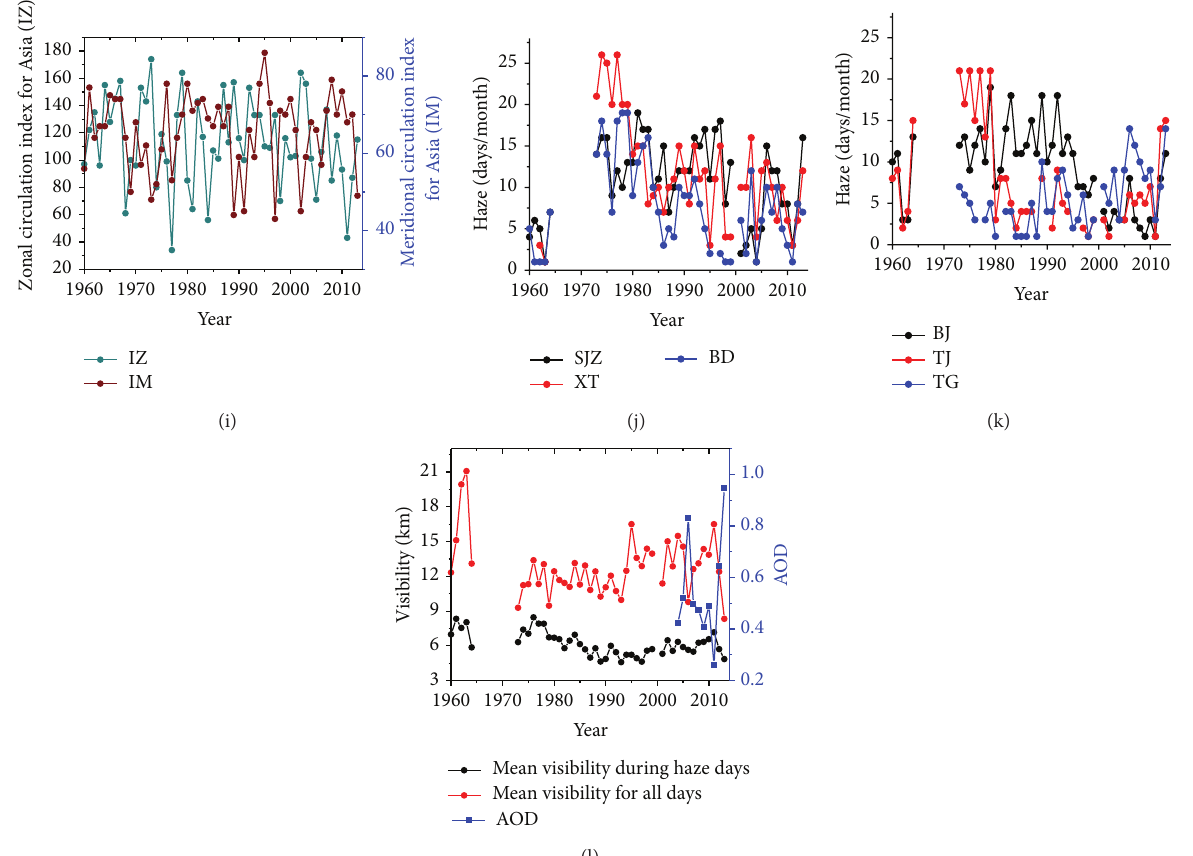
Figure 3: Interannual variations of (a) ∼ (e) precipitation, wind speed, temperature, relative humidity, and sunshine hours’ anomalies for the plains and mountainous sites, respectively; (f) ∼ (h) temperature, depression of the dew point, and wind speed at 850 hPa level anomalies at Beijing (BJ) and Xingtai (XT), respectively; (i) IZ and IM; (j) ∼ (k) the occurrences of haze at five urban sites (BJ, TJ, SJZ, BD, and XT) and a suburban site (TG); (l) mean visibility for all days and haze days and mean AOD over the BTH region in January. The climatology is calculated based on the mean in January from 1960 to